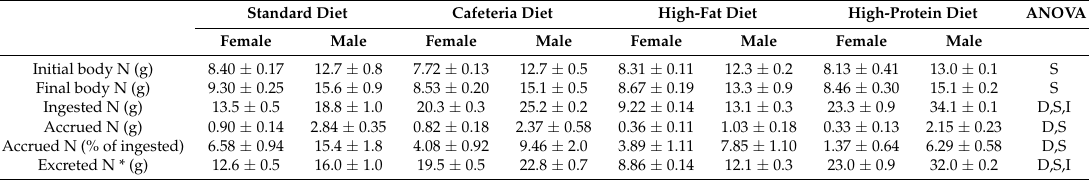
Table 3. Nitrogen balance of rats fed a control, cafeteria, high-fat, or high-protein diet for 30 days. Standard Diet Cafeteria Diet High-Fat Diet High-Protein